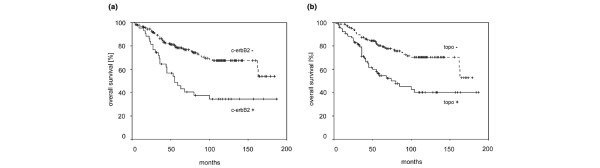
Overall survival of breast cancer patients with regard to c-erbB2 and topoisomerase IIα protein expression. (a) Patients with (solid line) or without (dashed line) c-erbB2 protein overexpression. The difference was significant in univariate statistical analysis (log rank 17.94; P < 0.0001). (b) Significant difference of survival time of patients with tumors positive for topoisomerase IIα protein in more than 25% of tumor cells (solid line) versus patients with tumors with less than 25% topoisomerase IIα-positive cells (dashed line) (log rank 15.59; P = 0.0001).